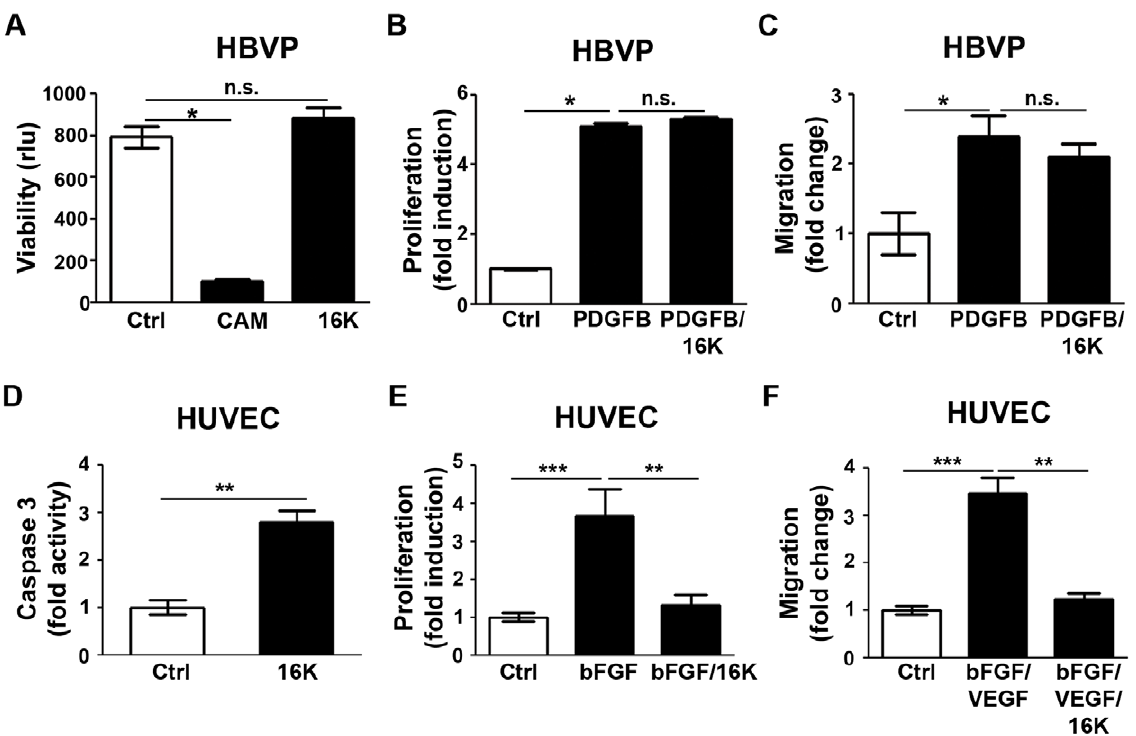
Figure 4. Endothelial cell specific effect of 16K hPRL. The response of human brain vascular pericytes (HBVP) and human umbilical vein endothelial cells (HUVEC) to 16K hPRL was examined. (A) HBVP viability was evaluated by means of the calcein assay. 16K: 100 nM 16K hPRL. Cam: camptothecin-treated cells, a positive control. Rlu: relative luminescence units. Each bar represents a mean 6 SEM, n=3. Two different experiments were performed. (B) HBVP were treated with 20 ng/ml PDGF-BB to stimulate proliferation and 100 nM 16K hPRL (16K). HBVP proliferation was assayed 48 h later by measuring BrdU incorporation. The data presented are means 6 SEM, n=5 and are representative of at least two independent experiments. (C) HBVP migration was assessed in a modified Boyden chamber (Costar, Corning Inc.). HBVP were treated for 17 h with 20 ng/ml PDGF- BB to stimulate migration and 100 nM 16K hPRL (16K). The data presented are means 6 SEM, n=3 and are representative of at least two independent experiments. (D) Apoptosis in HUVEC was assessed by quantification of Caspase-3 activity. HUVEC were treated for 16h with 50 nM 16K hPRL. (E) HUVEC were treated with 10 ng/ml bFGF to stimulate proliferation and 100 nM 16K hPRL (16K). HUVEC proliferation was assayed 24 h later by measuring BrdU incorporation. The data presented are means 6 SEM, n=5 and are representative of at least two independent experiments. (F) HUVEC migration in a scratch-wound assay 8 h after treatment with bFGF and VEGFA and with or without 50 nM 16K hPRL. The data presented are means 6 SEM, 5 measurements/condition, n=3 and are representative of at least two independent experiments. n.s., non significant.*, P , 0.05. **, P , 0.001. ***, P , 0.0001.